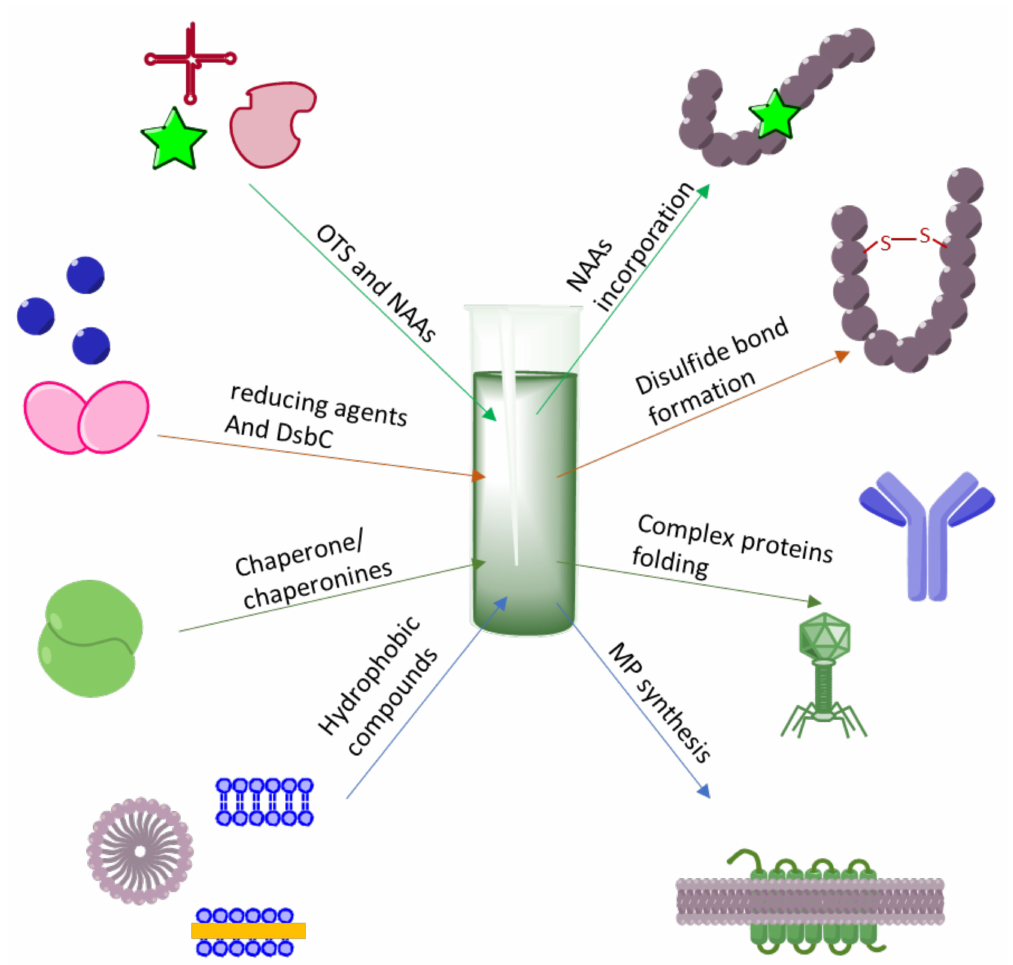
Figure 1. Schematic representation of CF methodology modification for the production of diverse proteins. Addition to the reaction mixture of orthogonal translation system (OTS) components and NAAs is required for the synthesis of site-specifically labeled proteins; reducing agents and disulfide-bond isomerase (DsbC) addition enables correct disulfide bond formation, while the presence of chaperons / chaperonins is required for complex proteins synthesis, such as antibody and virus-like particles (VLP); the presence of detergent micelles or lipid bicelles, membrane microsomes or nanodiscs is required for integral membrane protein (MP)